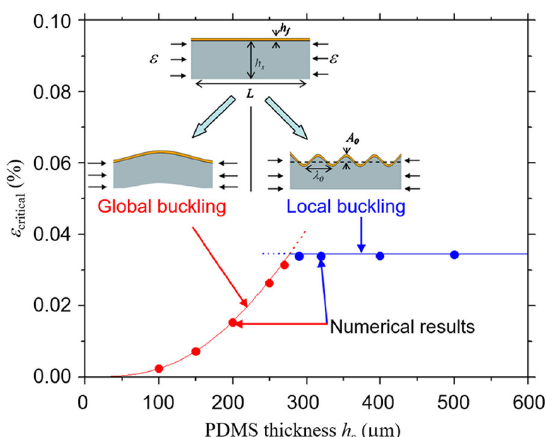
Fig. 3 Critical strains of local and global buckling vs. substrate thickness h s for Si/PDMS structures. (Reprinted with permission from ref. 16)